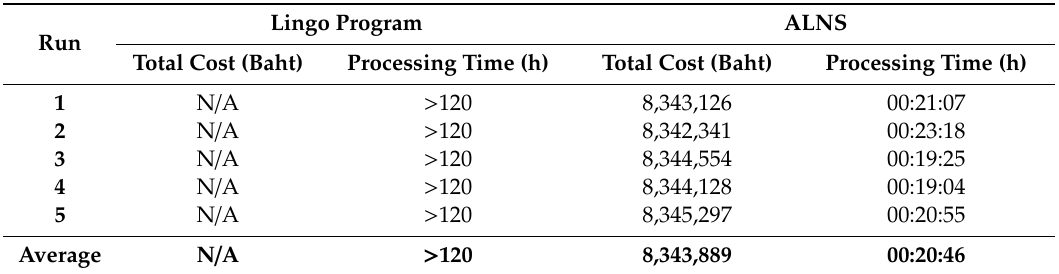
Table 10. Comparison of the proposed ALNS and Lingo on case study problem ( n = 80).